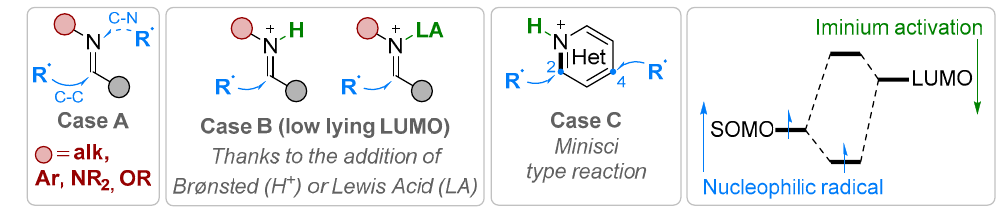
Figure 1. Radical addition to imine motifs and derivatives: general aspects.